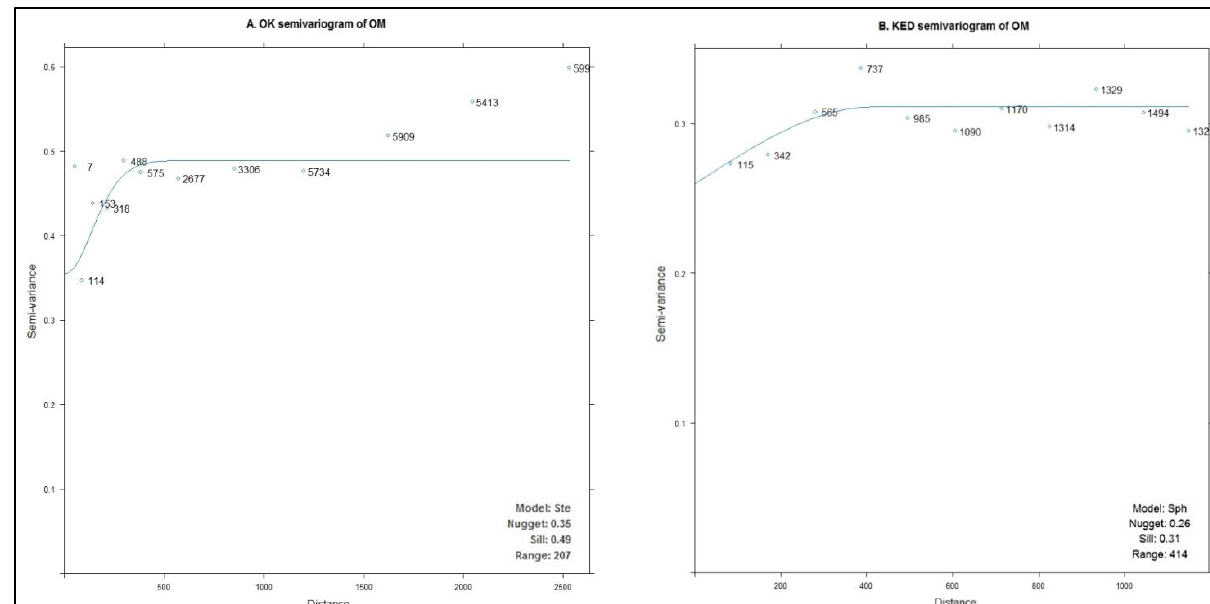
Figure 6. Empirical semivariogram and fitted model of OK and KED.